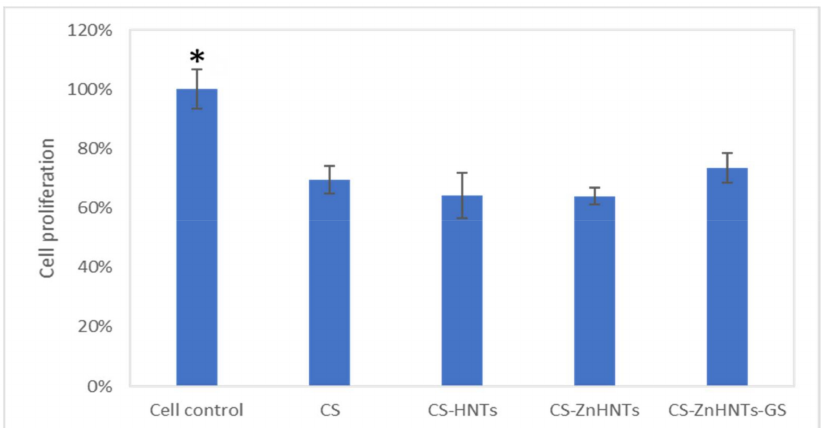
Figure 15. Proliferation assay for the Ti foil sca ff olds after 24 h of incubation. * = statistically significant at p <